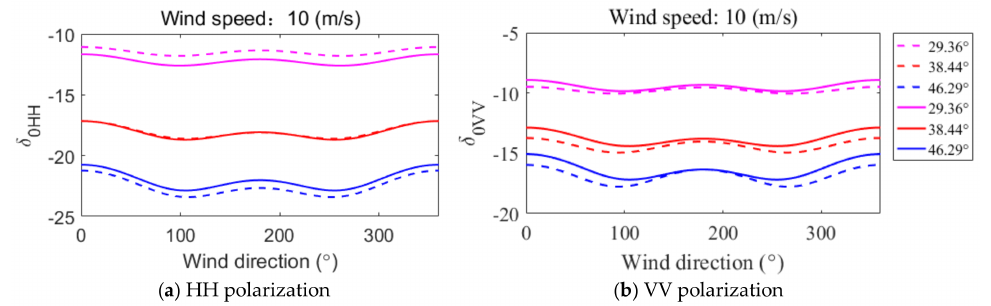
Figure 2. Comparison of WD dependence of the backscatter coefficient for: HH polarization ( a ); and VV polarization ( b ), using GMF of Isoguchi and Shimada for PALSAR (solid line) and Meissner et al. (2014) for Aquarius (dashed line) at 10 m/s. The incident angles are chosen as 29.36 ◦ (mauve), 39.44 ◦ (red) and 46.29 ◦ (blue).